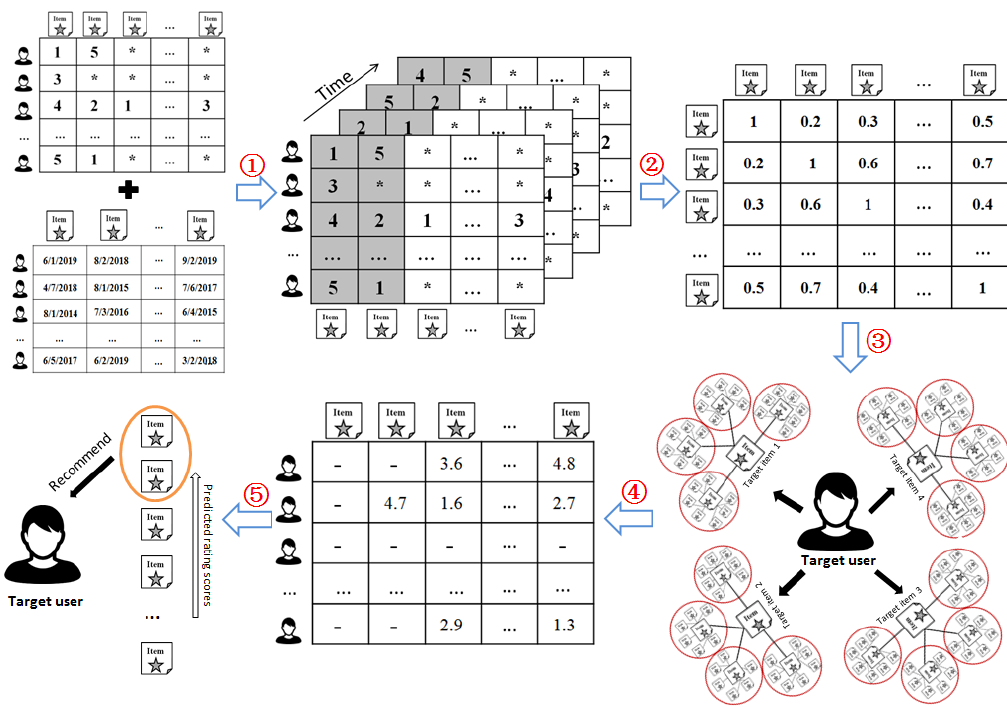
Figure 1. The flow chart of proposed approach. Our approach comprises the following main phases: ① combine user-item rating matrix and user-item time matrix; ② apply the proposed item-related correlation degree function into similarity measure to compute item-item similarity; ③ further select the neighborhood for each similar item of a target item; ④ insert proposed covering degree function into rating prediction; ⑤ recommend top N items with highest predicted rating scores.